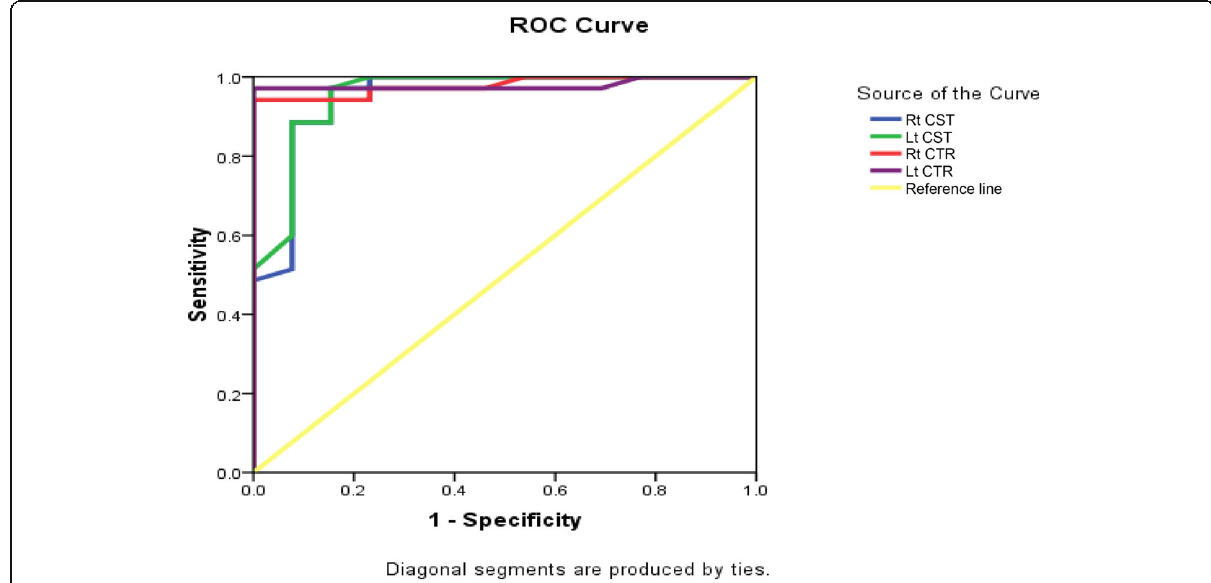
Fig. 1 ROC curve application for determination of sensitivity and specificity of FA values in (CST and CTR) in CP diagnosis